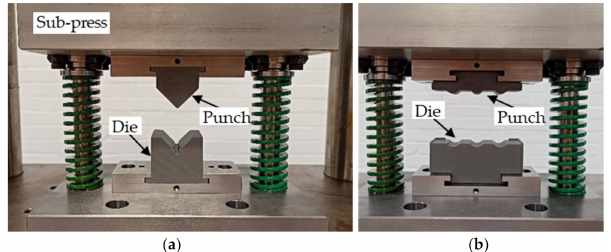
Figure 2. Sub-press with tools mounted for ( a ) V-bending and ( b ) groove pressing.